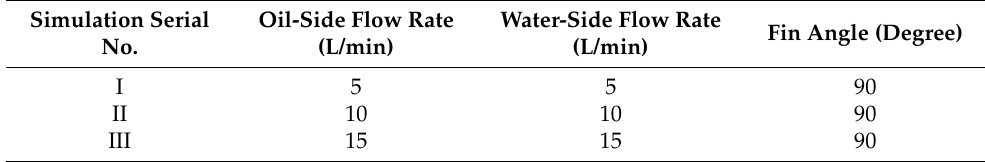
Table 5. Three simulated cases for validation via η